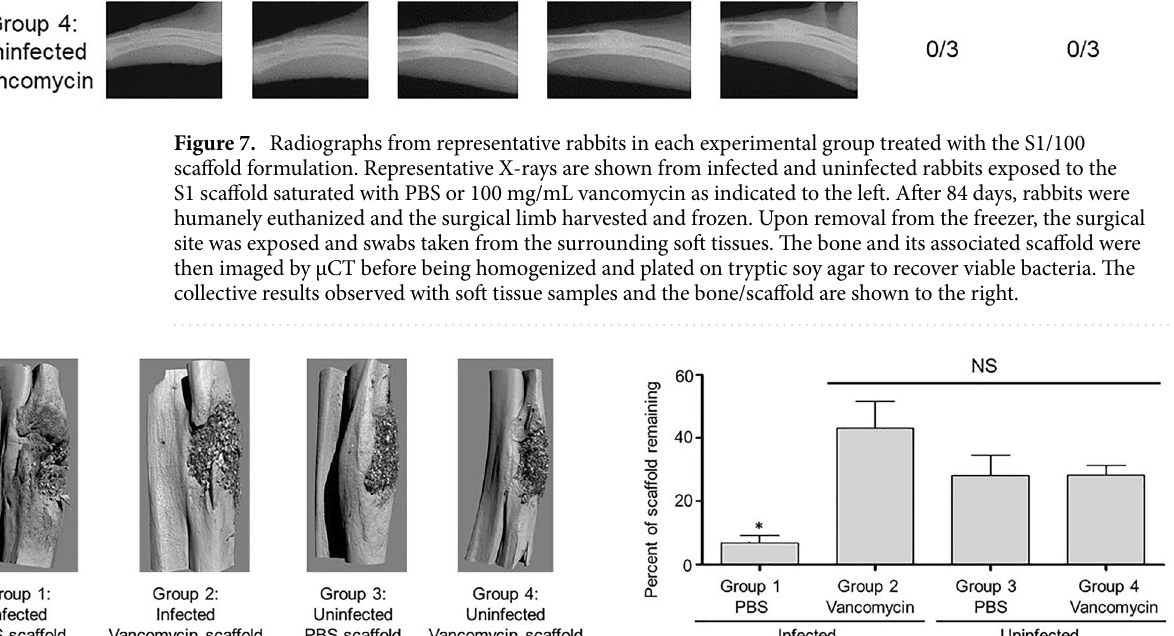
Figure 8. µCT analysis of S1/100 scaffold in situ. Left: Bone surrounding the surgical site was harvested and subjected to µCT analysis. Results shown are from representative rabbits from each experimental group, with the specific experimental group indicated below each panel. Analysis is based on results observed after 84 days. Right: The amount of scaffold remaining at the surgical site was calculated by comparison to control scaffolds prior to implantation. Results shown are the average ± the standard error of the mean for each experimental group. Asterisk indicates a statistically significant difference by comparison to the uninfected control group that obtained PBS-saturated scaffold (Group